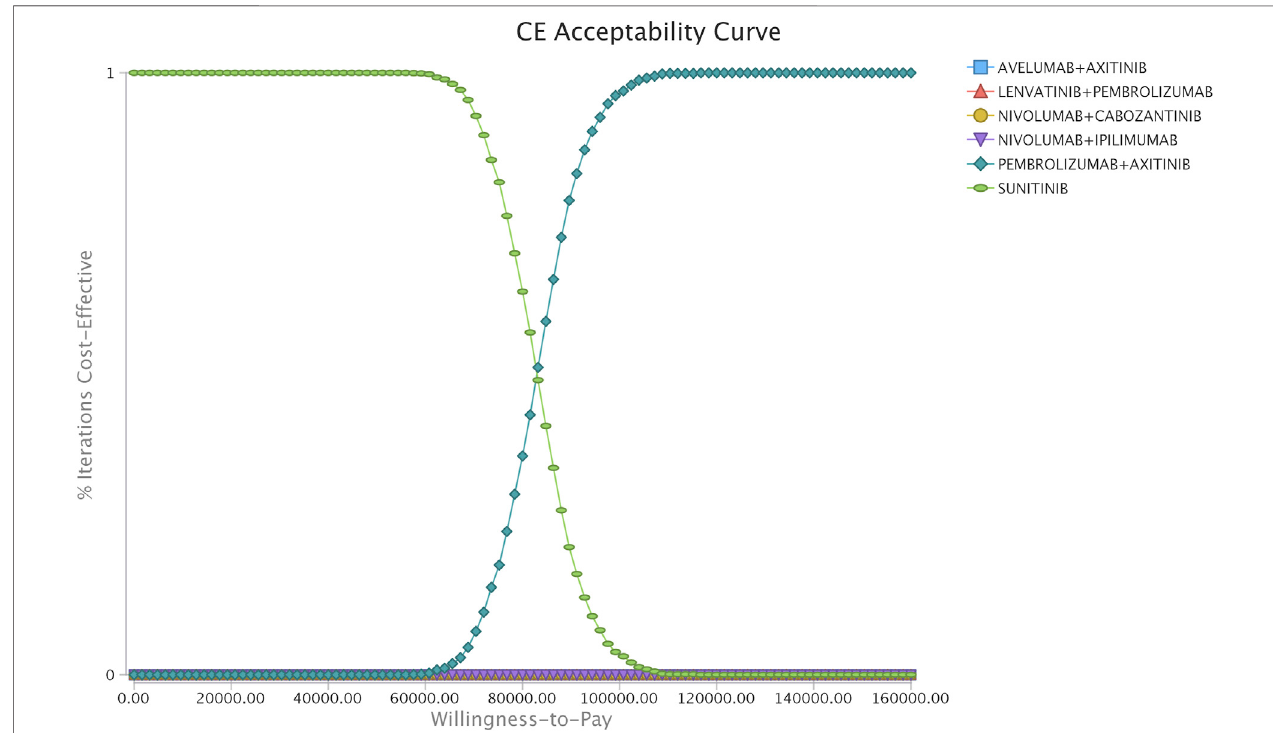
FIGURE 2 | Acceptability curves comparing the cost-effectiveness of different competing strategies in the scenario of the simultaneous competition of six strategies.